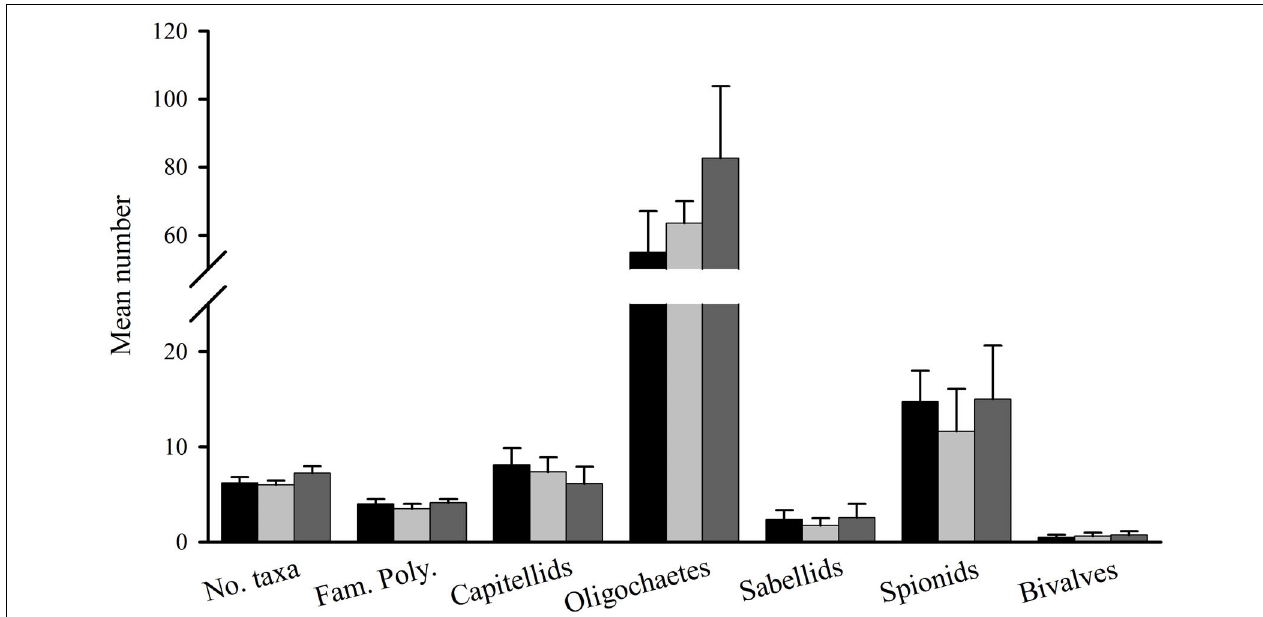
FIGURE 3 | Gore Creek macrofauna after 2 weeks, mean ( SE ; n = 4 plots) number of taxa, families of polychaetes and abundances of capitellids, oligochaetes, sabellids, spionids, and bivalves in plots with black roofs (black bars), clear roofs (dark gray bars), or control plots (light gray